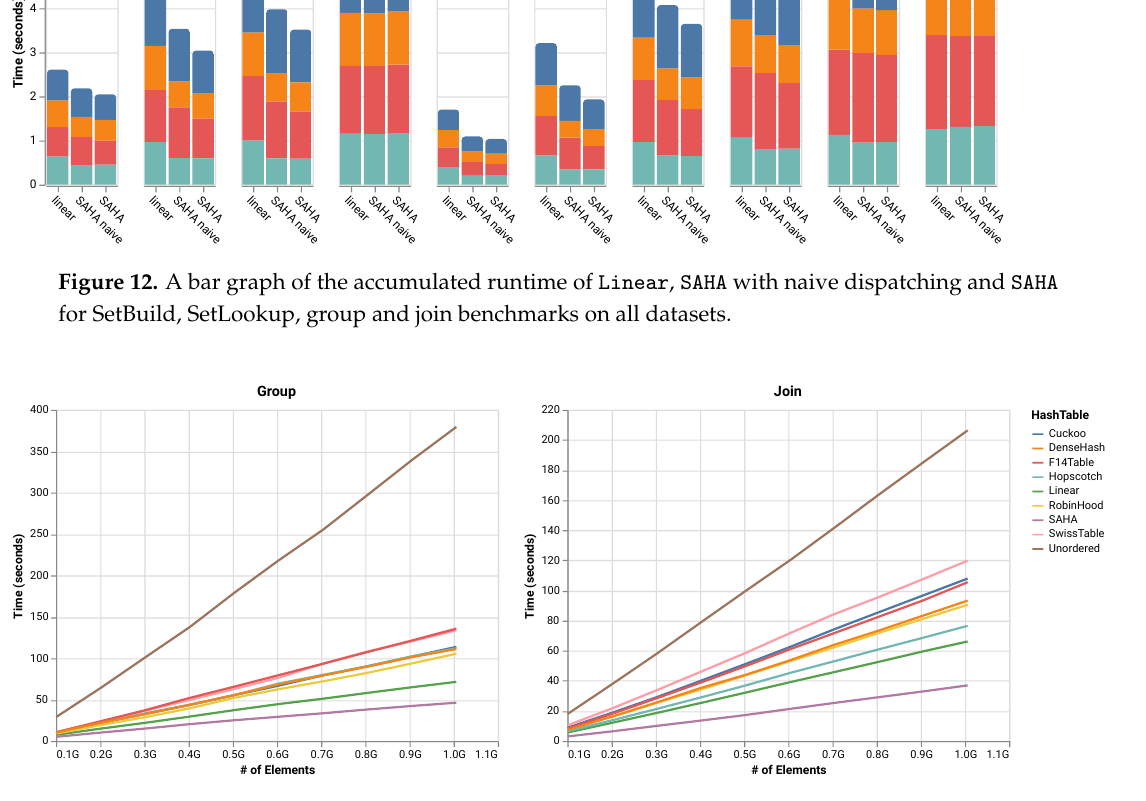
Figure 13. A line figure of time consumption of various hash tables for group and join benchmarks on the real world Weibo